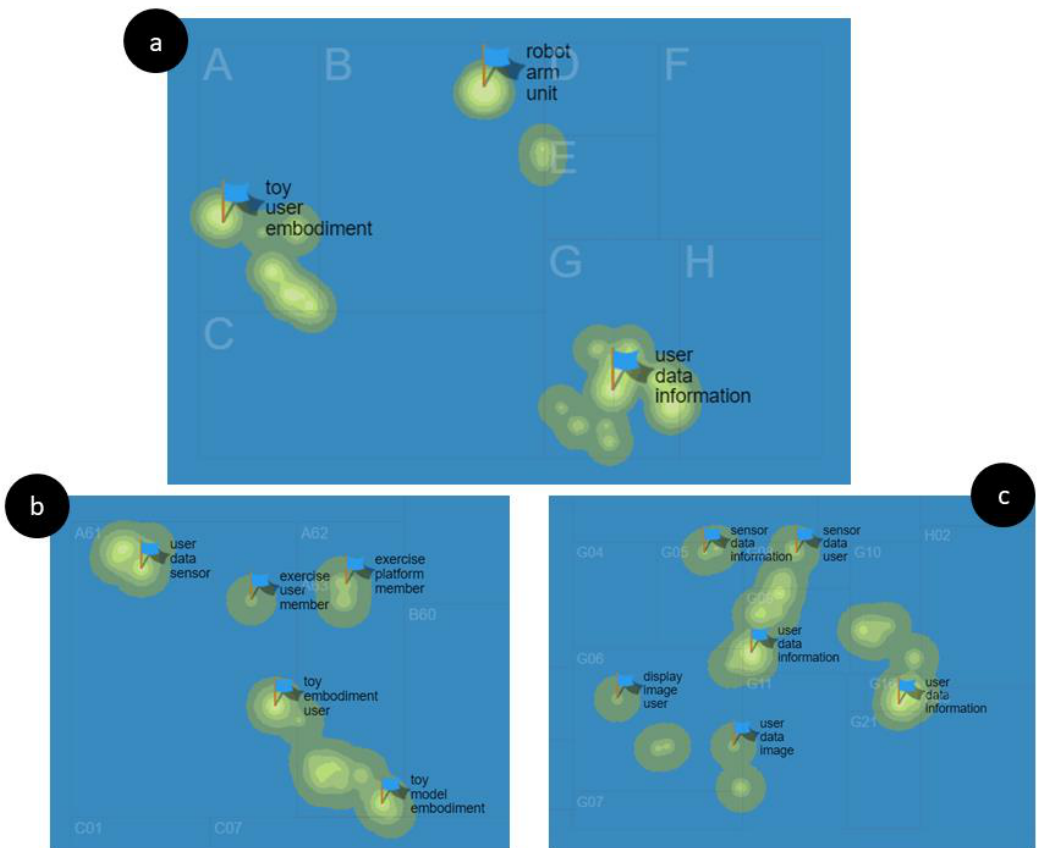
Figure 6. IPC Code Map for patent sample: ( a ) areas of scope of the selected sample ( b ) (1) A-HUMAN NECESSITIES areas, and ( c ) (2) G-PHYSICS areas.